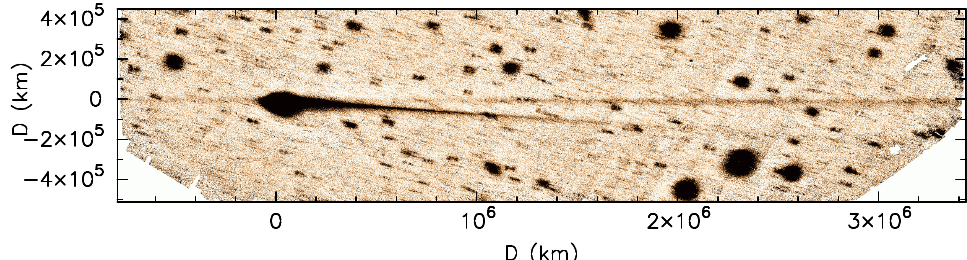
Figure 3. Trail and neck-line image of comet 67P obtained on 8 March 2016, at a heliocentric distance of 2.53 au, using the Hyper Suprime-Cam (HSC) on the 8.2-m Subaru telescope at Mauna Kea. The image is oriented so that the trail appears horizontally. Distances ( D ) are projected distances at the nucleus position in the sky. Adapted from [57].